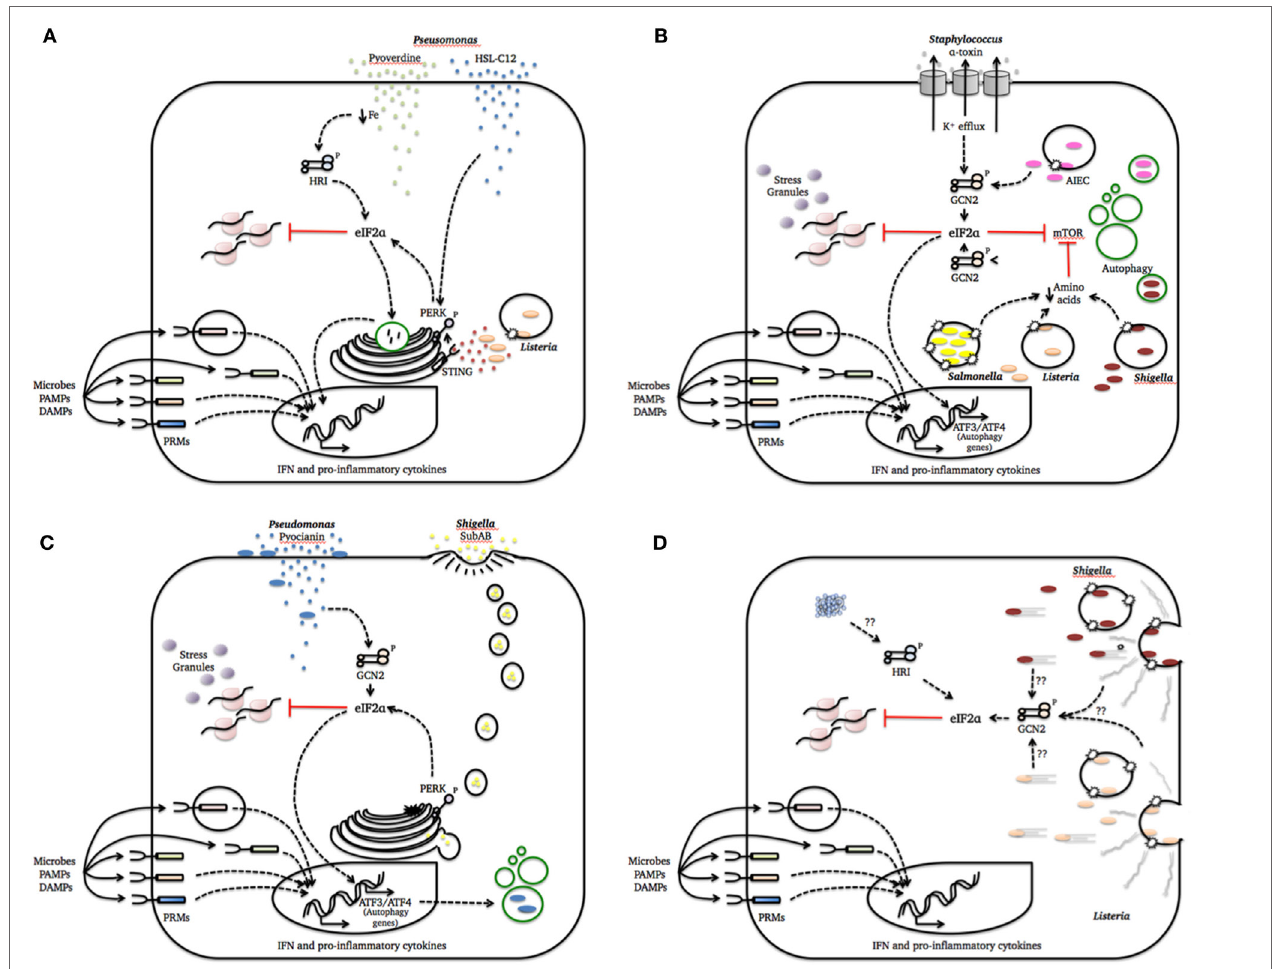
FigURe 1 | Integrated stress response (ISR) activation by bacterial pathogenesis patterns. This figure summarizes how cellular damage induced by different bacterial species is sensed by one or more eukaryotic translation initiation factor 2 alpha (eIF2 α ) kinases to activate defense mechanisms and homeostatic programs. We intentionally included a simplified representation of pattern recognition molecules (PRMs) recognition of microbes, PAMPs, and danger-associated molecular patterns (DAMPs) in all cartoons to strengthen the notion that these system act together to refine the cell response to the infection. (A) Pathogenesis pattern: bacterial growth; (B) pathogenesis pattern: membrane damage; (C) pathogenesis pattern: access to cytosol; (D) pathogenesis pattern: cytoskeleton disruption and protein